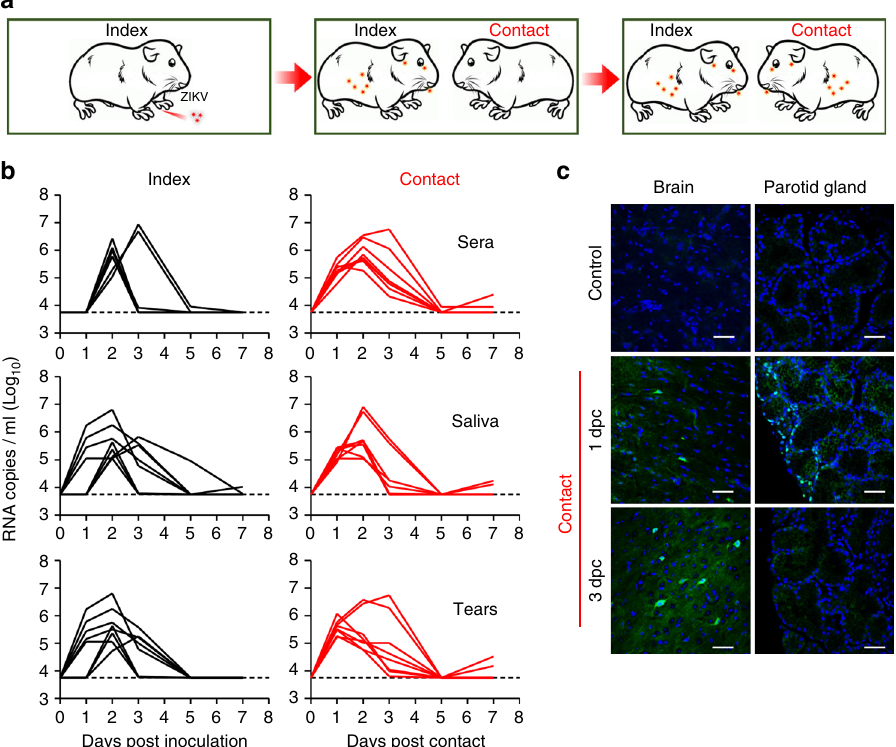
Fig. 2 Close contact transmission of ZIKV in guinea pigs. a Schematic diagram of the close contact experiments. Brie fl y, each male guinea pig that received s.c. inoculation of ZIKV was placed in an isolated cage, then the other naïve male animal was co-caged at 1 or 3 dpi. b Serum, saliva, and tear samples were collected from the index ( n = 8) and contact ( n = 8) animals and subjected to viral load analysis. c Immunostaining of selected tissues from the contact animals at 1 and 3 dpc. Scale bar: 50 μ